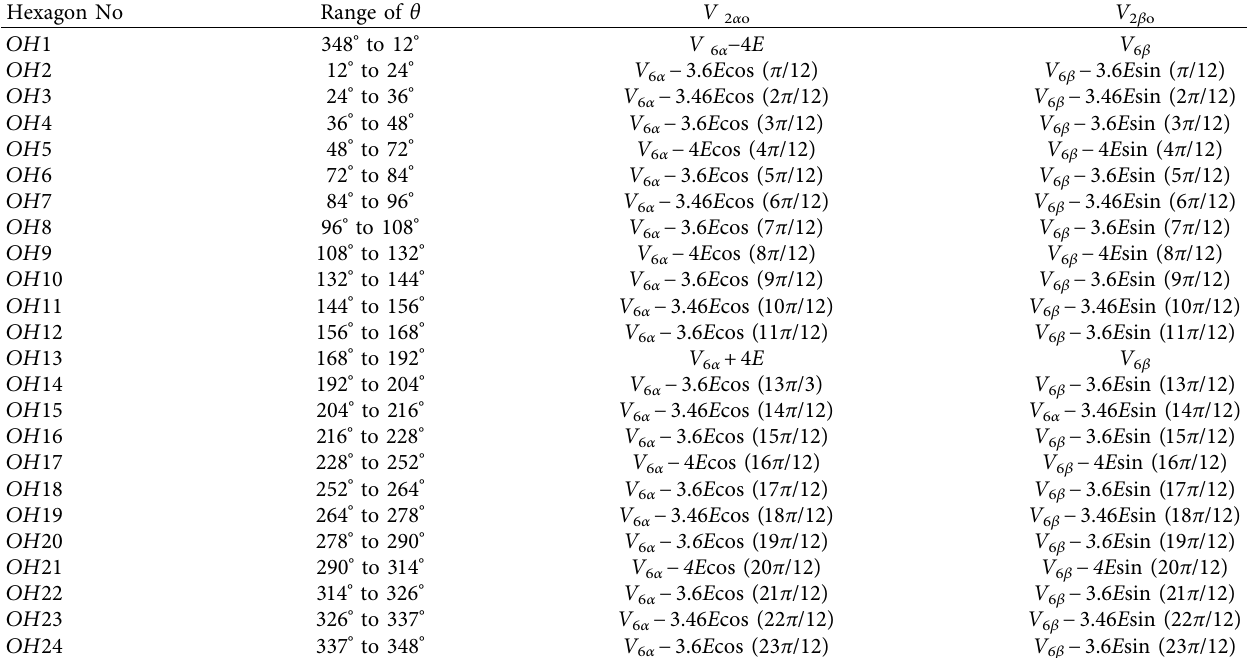
ref2O from V ref6 .